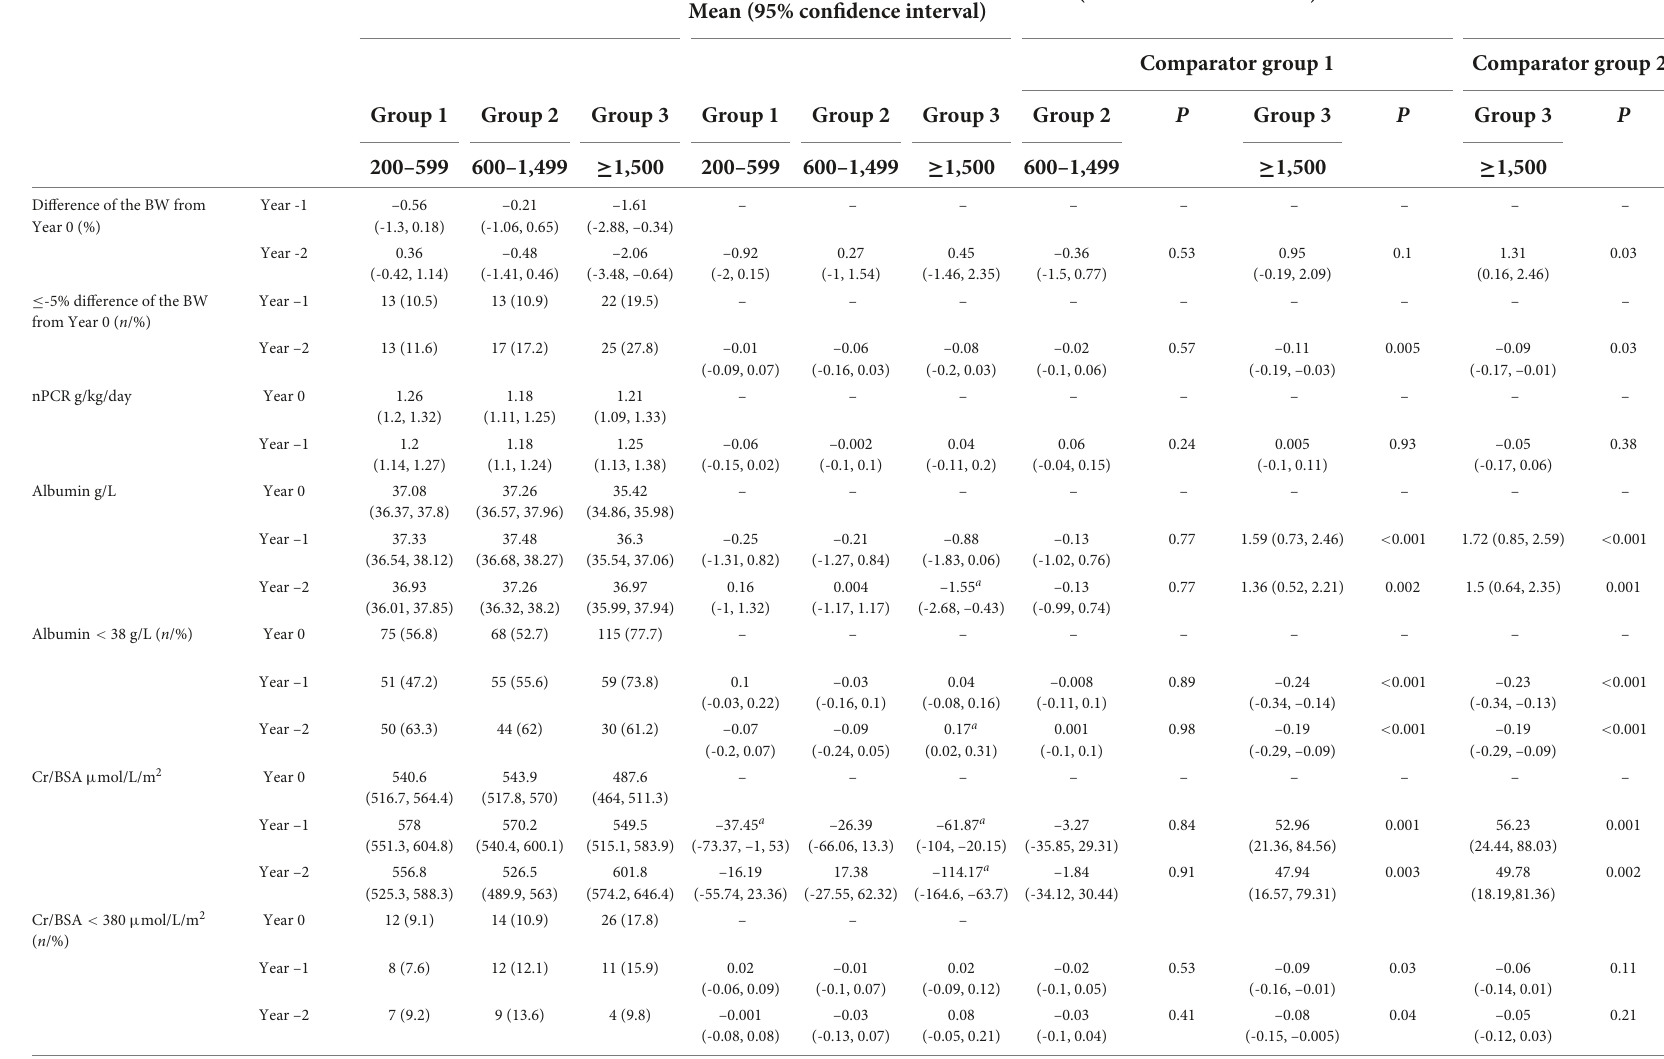
TABLE 3 Mixed-effects regression analyses on the differences in nutritional parameters between baseline and the preceding 1 and 2 years.